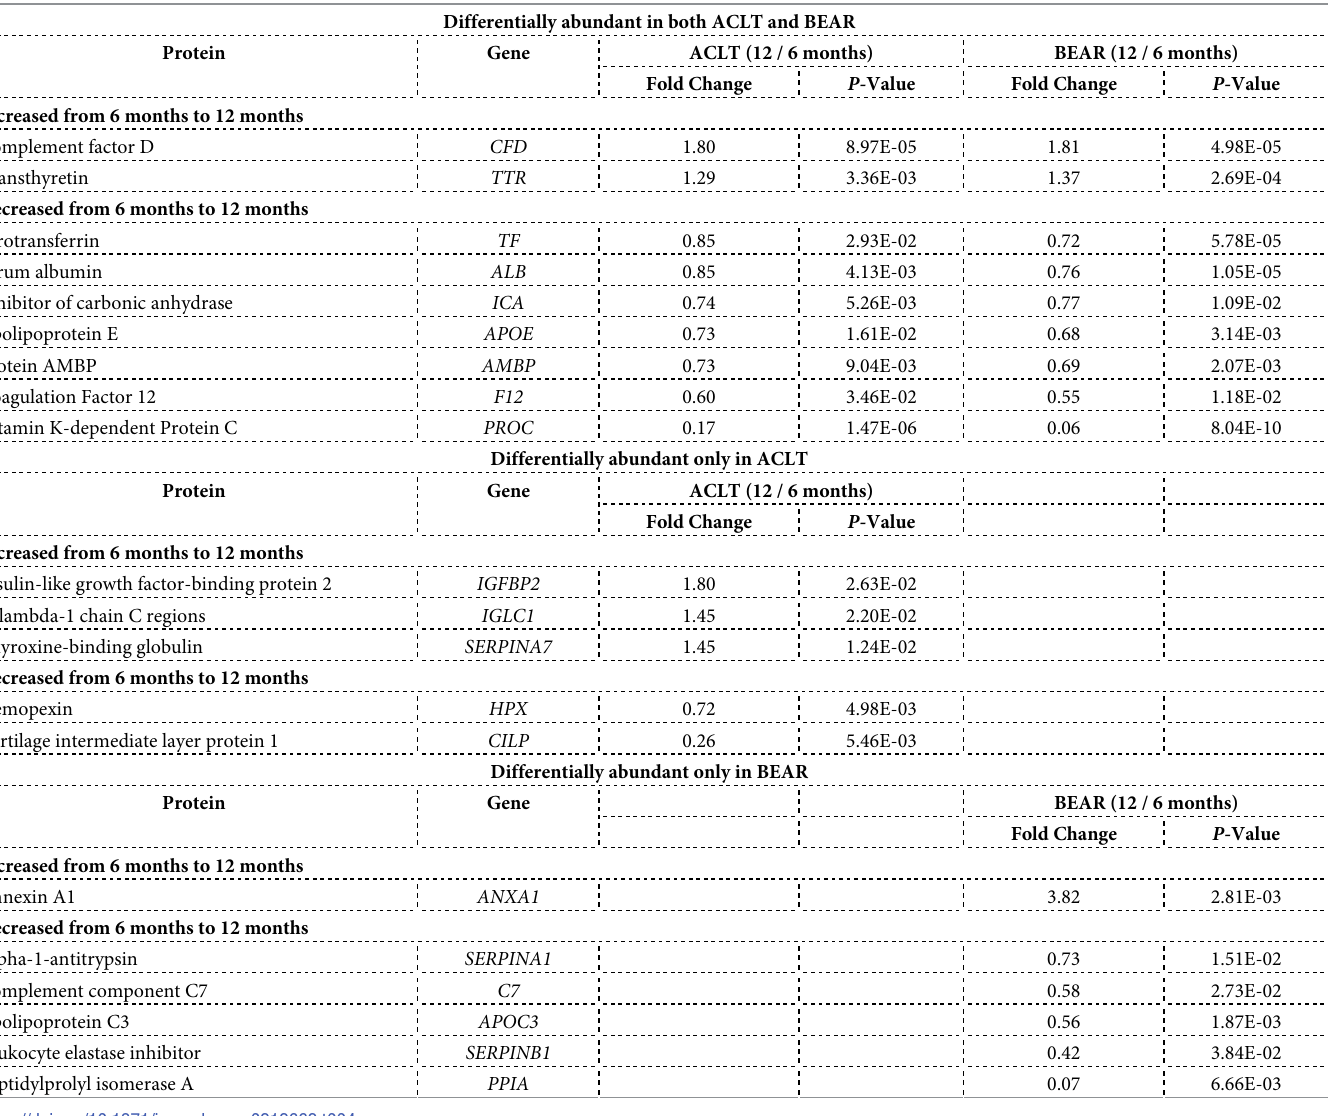
surgery, there was significantly greater cartilage damage in the knees with an untreated ACL damage was accompanied by differences in the proteome between the groups at 12 months, with the ACLT group having a higher concentration of Vitamin K-dependent Protein C (2.4 fold), and a decreased content of Apolipoprotein A4 (0.7 fold) and Cartilage intermediate layer protein 1 (0.35 fold) when compared to the BEAR knees. In addition, there was also a dif- ference in the proteins which significantly changed in abundance between 6 and 12 months (Table 4), with Insulin-like growth factor-binding protein 2 (IGFBP2), Ig lambda-1 chain C regions (IGLC1), Hemopexin and CILP changing in the ACLT group, and significant changes